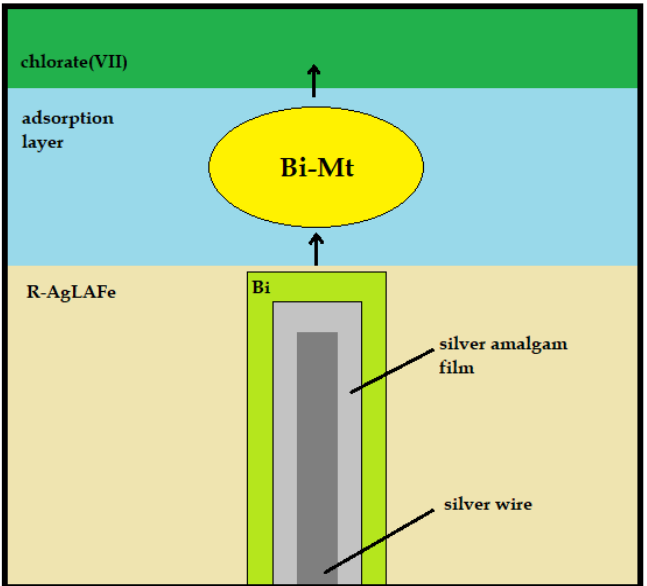
Figure 7. The reaction path obtained for Bi(III) ion electroreduction in the presence of methionine.